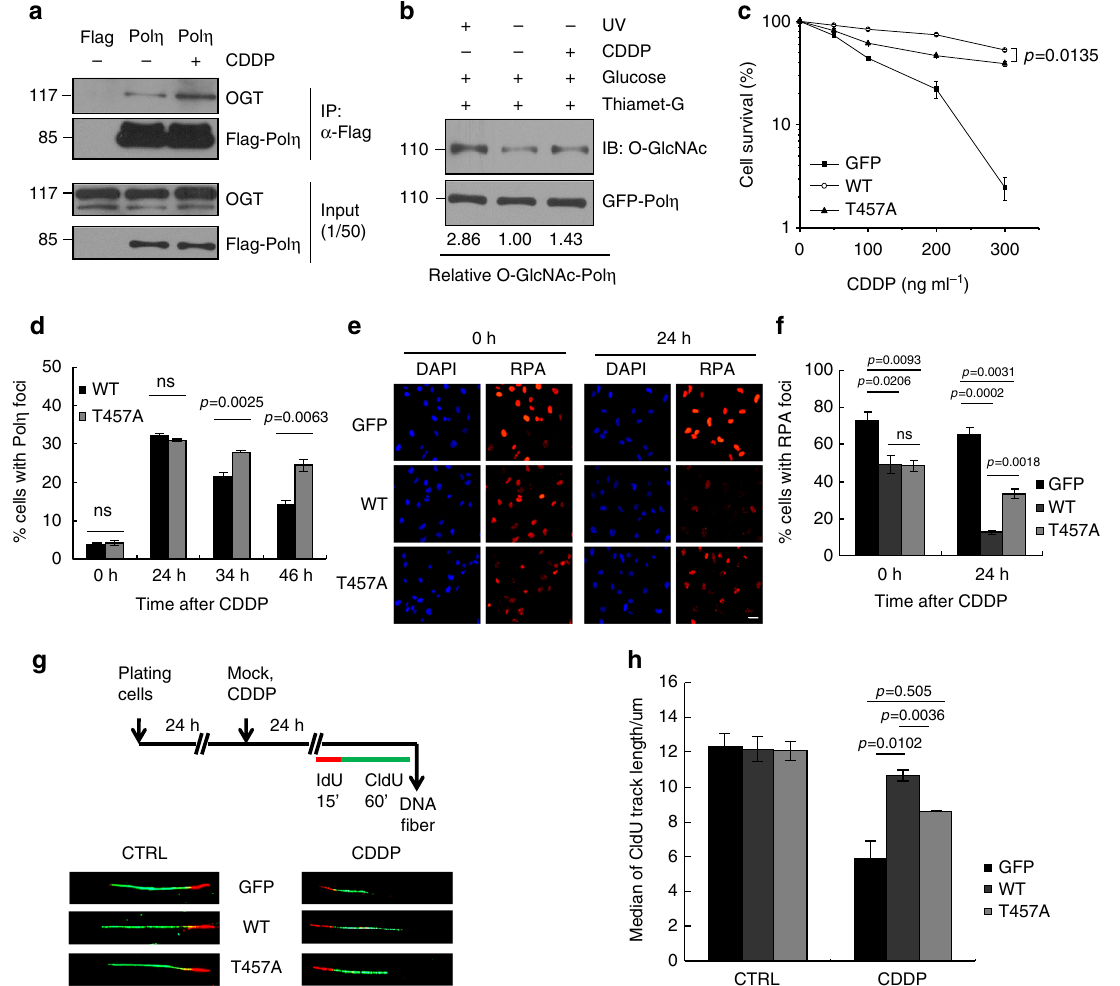
Fig. 6 T457 affects Pol η TLS ef fi ciency after cisplatin treatment. a 293T cells transfected with Flag-Pol η were treated with CDDP (10 µ g ml − 1 ) for 2 h and changed to drug-free media for 2 h. The cell lysates were harvested for immunoprecipitation assay as in Fig. 1e. b 293T cells transfected with GFP-Pol η were treated with Thiamet-G and glucose. Cells were treated with UVC (15 J m − 2 ) irradiation or cisplatin (10 µ g ml − 1 ) and harvested at 4 or 2 h later, respectively. The cell lysates were immunoprecipitated with GFP-Trap A and analyzed with anti-O-GlcNAc and anti-GFP antibodies. c XP30RO cells stably expressing GFP, WT, or T457A GFP-Pol η were treated with cisplatin for 24 h and further incubated for 7 – 10 days. Cell survival was analyzed as in Fig. 3f. d U2OS cells transfected with WT or T457A GFP-Pol η were treated with cisplatin (5 µ g ml − 1 ) for 2 h followed by incubation with fresh media. At the indicated time points, the proportion of GFP-Pol η expressing cells with > 30 foci was determined. e Representative images of cells stained with DAPI and RPA2 after cisplatin treatment. XP30RO cells stably expressing GFP, WT, or T457A GFP-Pol η were treated with cisplatin for 24 h and further cultured. At the indicated time points, cells were immunostained with anti-RPA2 antibody. Scale bars: 10 μ m. f Quanti fi cation of the percentage of cells with > 10 RPA2 foci. g Scheme of experimental design for replication fork progression in XP30RO cells stably expressing GFP, WT, or T457A GFP-Pol η . After cisplatin (1 µ g ml − 1 ) treatment for 24 h, representative DNA fi bers were shown. h Median lengths of nascent replication tracts (labled with CIdU) were given. Data represent means ± SEM from three independent experiments. ns not signi fi